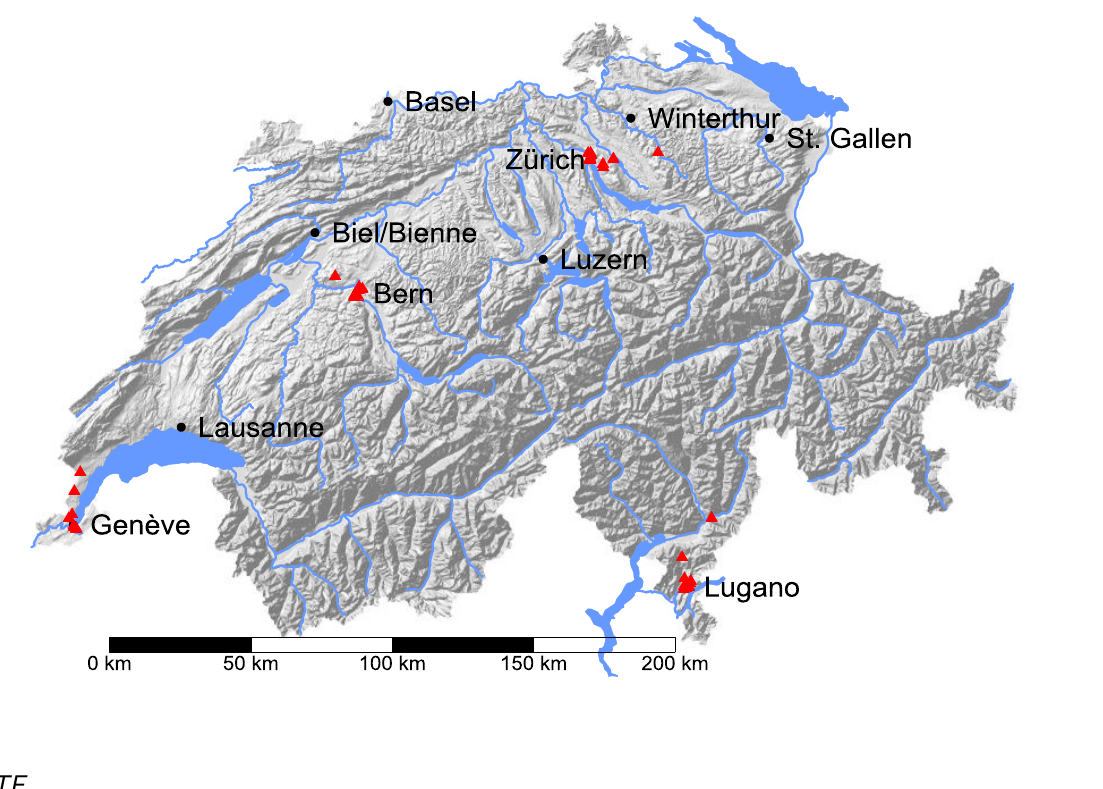
Figure 1. Location of the UMTS base station sample (red triangles) on the map of Switzerland. As the stations in the sample are strongly clustered, it is difficult to distinguish individual sites at this map scale. Background map data © 2014 BfS ThemaKart (vector data) and Swisstopo